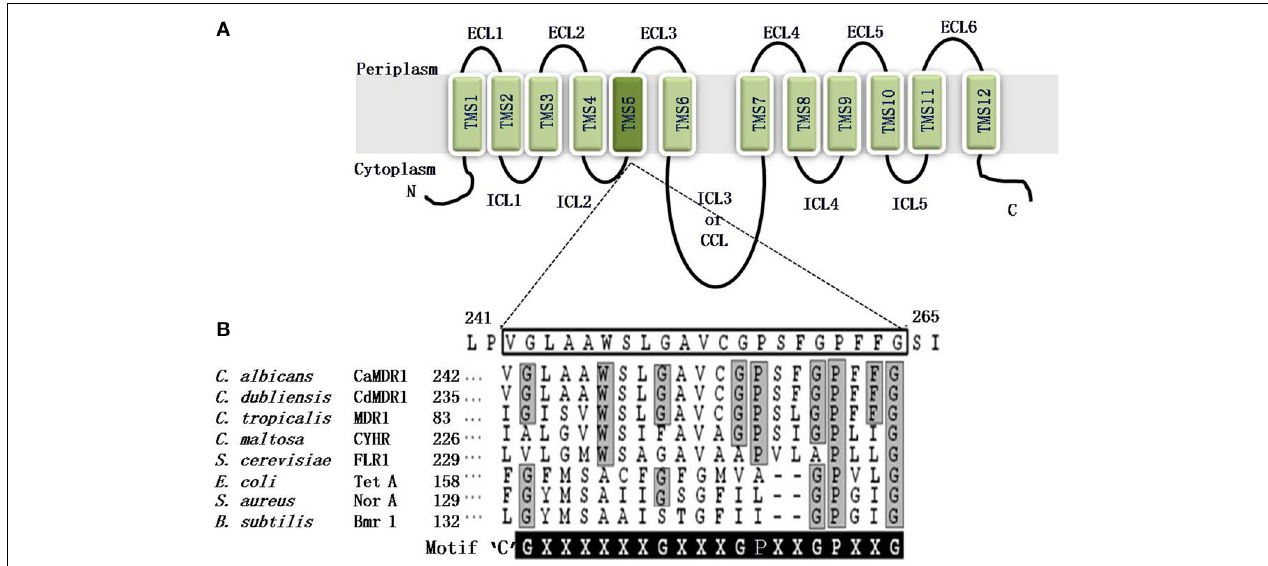
FIGURE 5 | (A) Predicted topology of the CaMdr1p with 12 transmembrane segments. The amino and carboxyl terminals of protein are indicated. Six extracellular loops (ECL1-6) and five intracellular loops (ICL1-5) are indicated. Two homologous halves are connected by a central cytoplasmic loop (CCL) or ICL3. The TMS5 is colored dark and magnified to show the amino acid residues of TMS5. (B) Alignment of the protein sequences of the C. albicans antiporter CaMdr1p TMS5 with the other fungal and